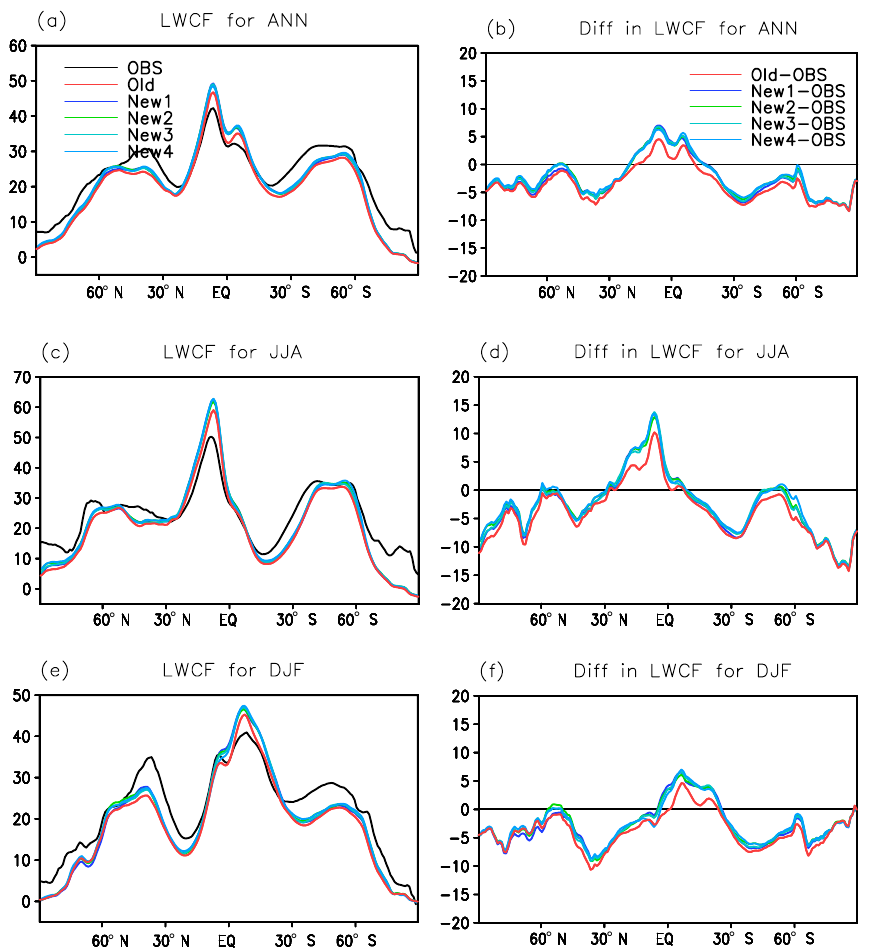
Figure 3. Annual, JJA, and DJF zonal mean of longwave cloud radiative forcing (LWCF, Wm − 2 ) derived from CAM5.1 ( a , c , and e ) and the CERES-EBAF observations (OBS), and their difference between OBS and Old, as well as News ( b , d , and f